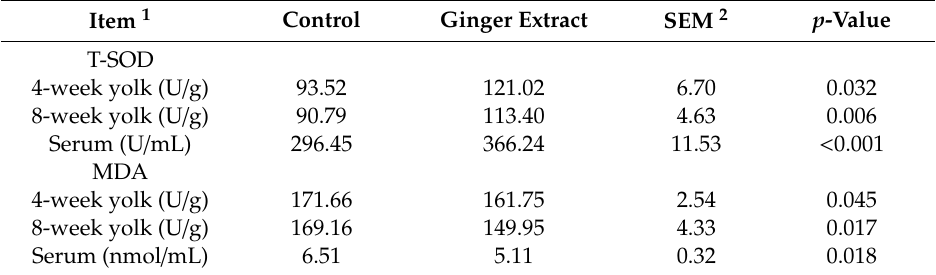
Table 6. E ff ects of ginger extract on antioxidant status of laying